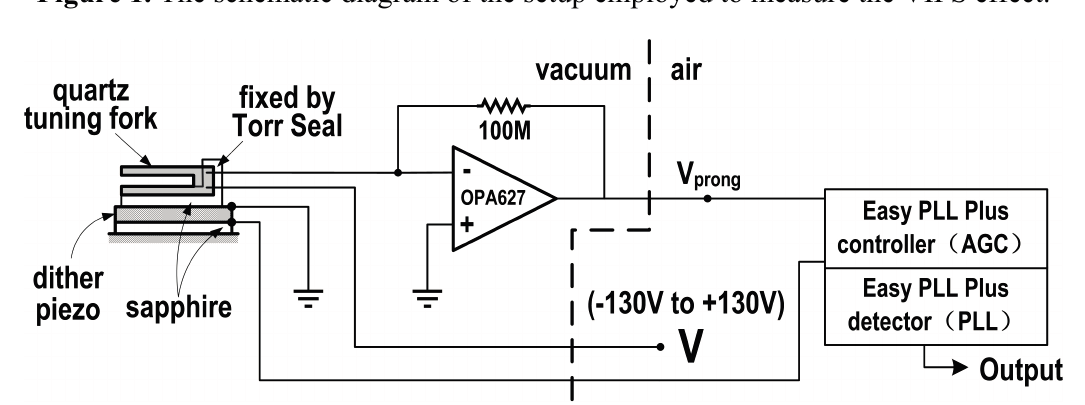
Figure 1. The schematic diagram of the setup employed to measure the VIFS